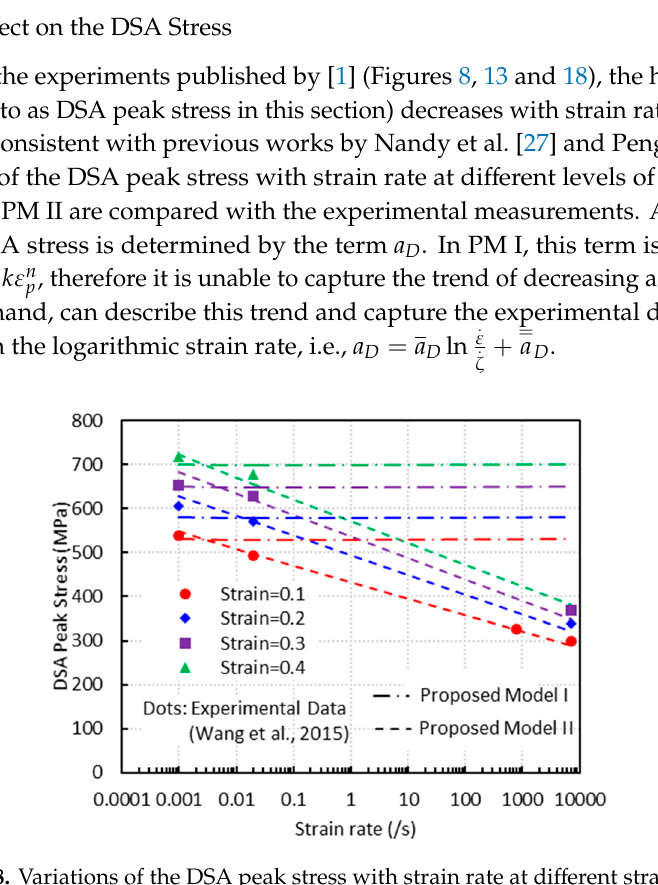
Figure 18. Variations of the DSA peak stress with strain rate at different strain levels.